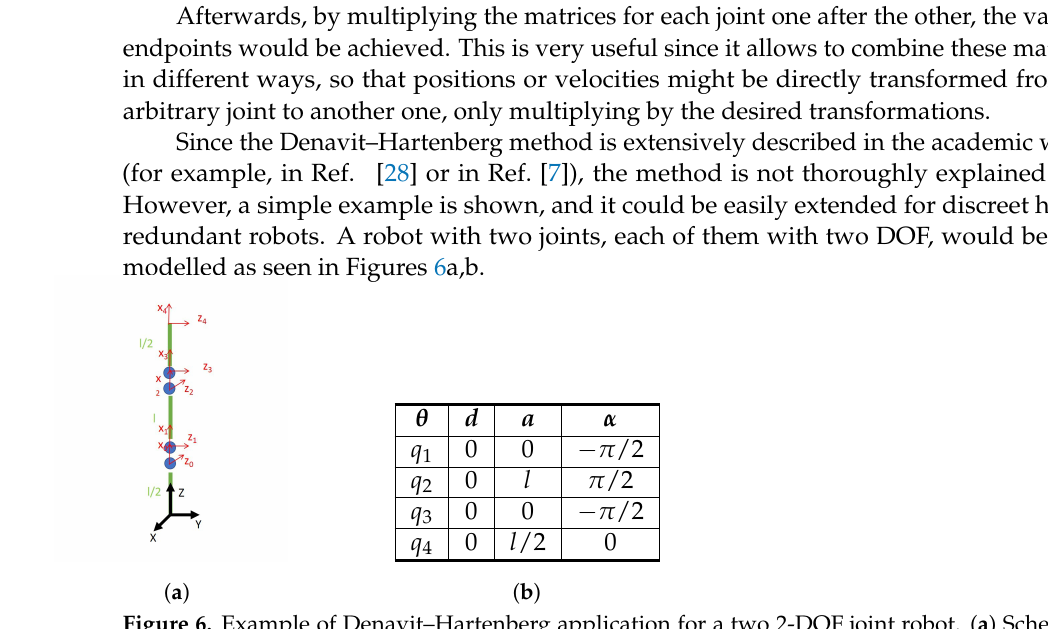
Figure 6. Example of Denavit–Hartenberg application for a two 2-DOF joint robot. ( a ) Schematic figure for the application of the Denavit–Hartenberg algorithm to a simple kinematic joint chain. ( b ) Denavit–Hartenberg parameters for such